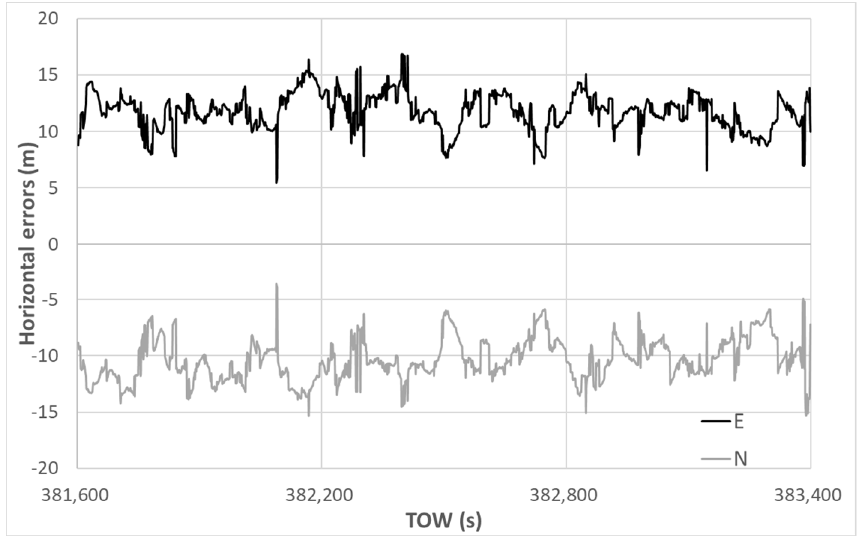
Figure 20 . DGNSS horizontal errors. Figure 20. DGNSS horizontal